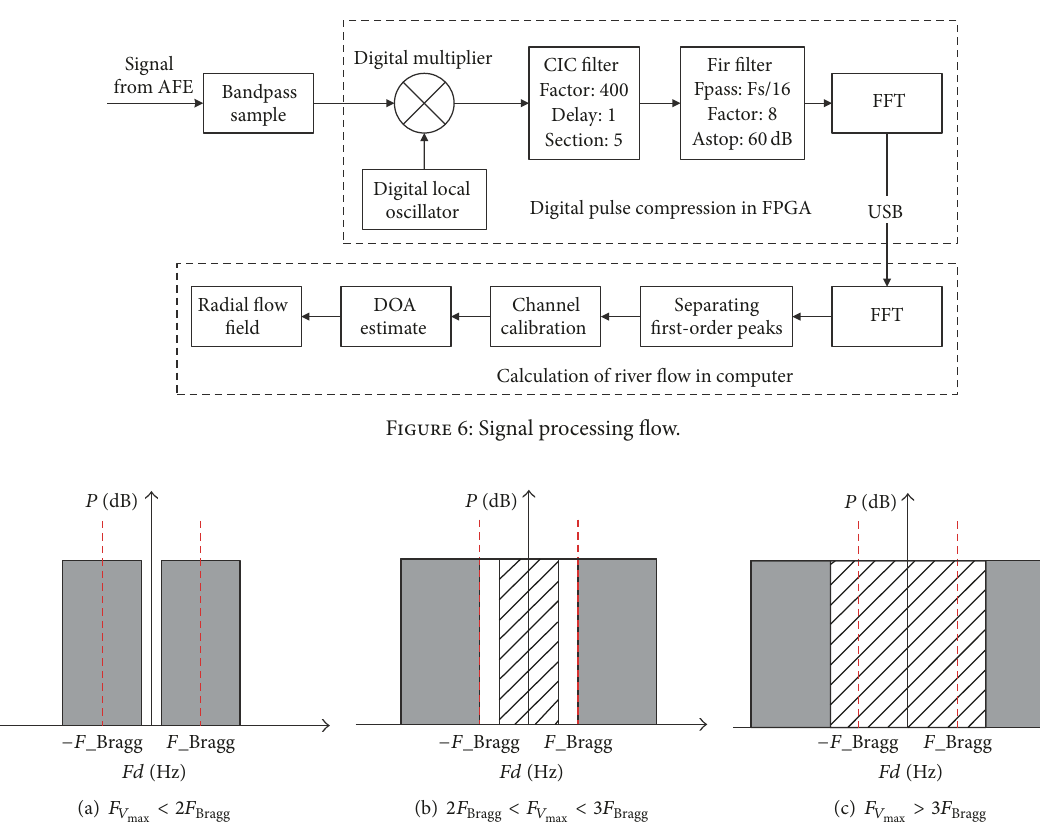
Figure 7: Doppler-broadened spectra in varying